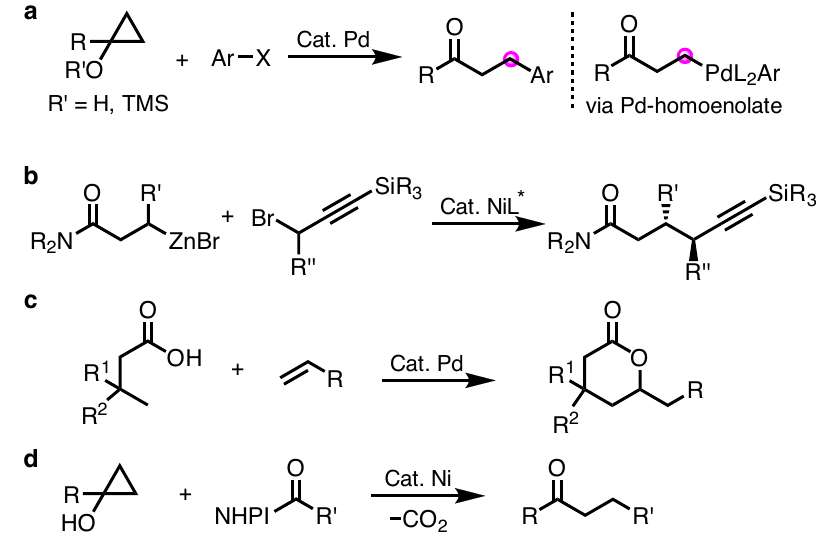
Fig. 1 Metal catalyzed functionalization of homoenolates and their higher homologs. a Palladium-catalyzed arylations of cyclopropanol derivatives. b Ni-catalyzed doubly stereoconvergent coupling. c Palladium-catalyzed functionalization of γ -C – H ’ s of carboxylic acid derivatives. d Ni-catalyzed alkylations with N -hydroxyphthalimides